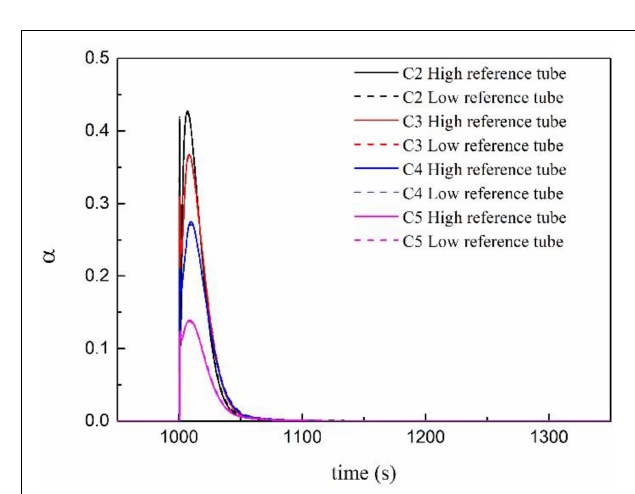
FIGURE 5 | Void fraction at the bottom of water space under different conditions.